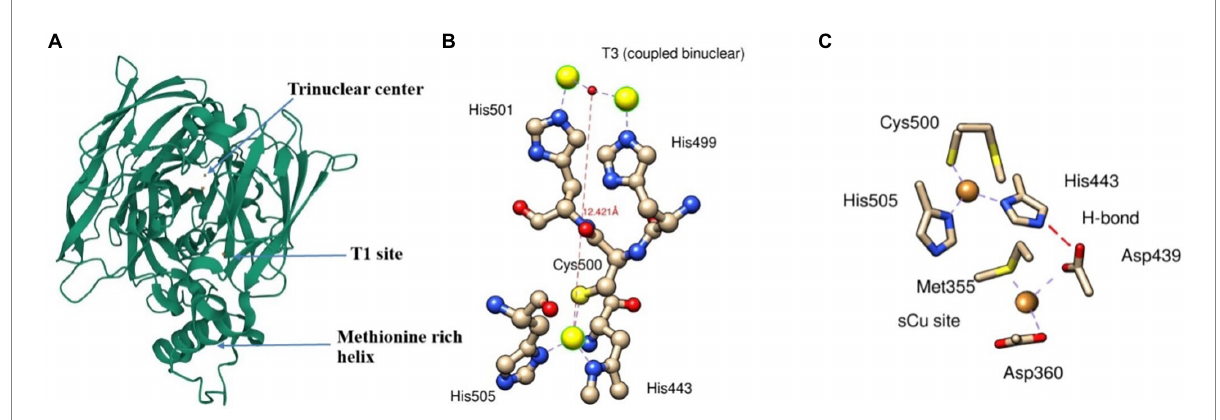
FIGURE 3 A ribbon diagram of CueO (PDB: 3OD3) showing (A) Trinuclear site, T1 site, and methionine rich helix, (B) interaction of T1 and T3 sites with its respective amino acids residue*, and (C) electron transfer from sCu into T1 site between Asp 439 , sCu, and His 443 . *Interaction of T3 site with T2 is not shown.